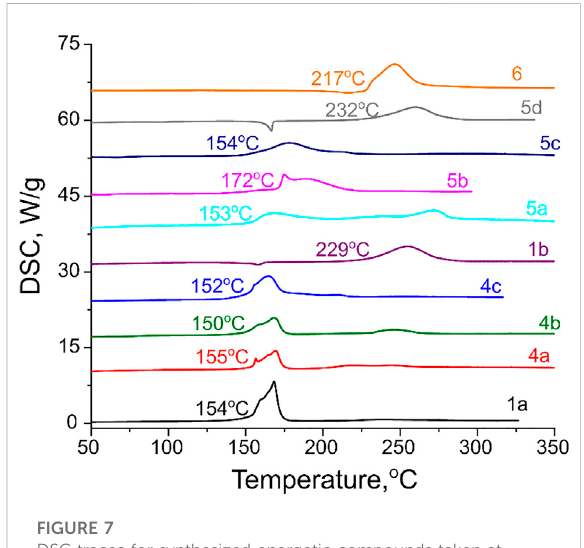
FIGURE 7 DSC traces for synthesized energetic compounds taken at 5 K min − 1 heating rate. The extrapolated onsets of exothermic decomposition peaks are